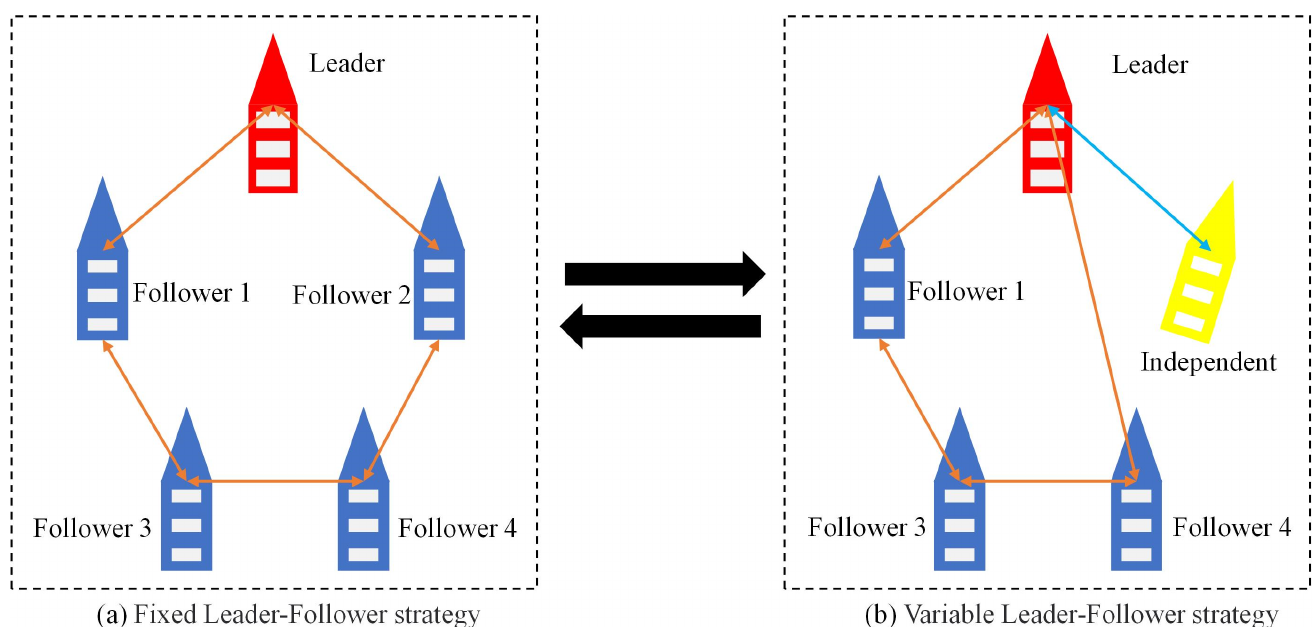
Figure 5. Strategy of Leader–Follower.